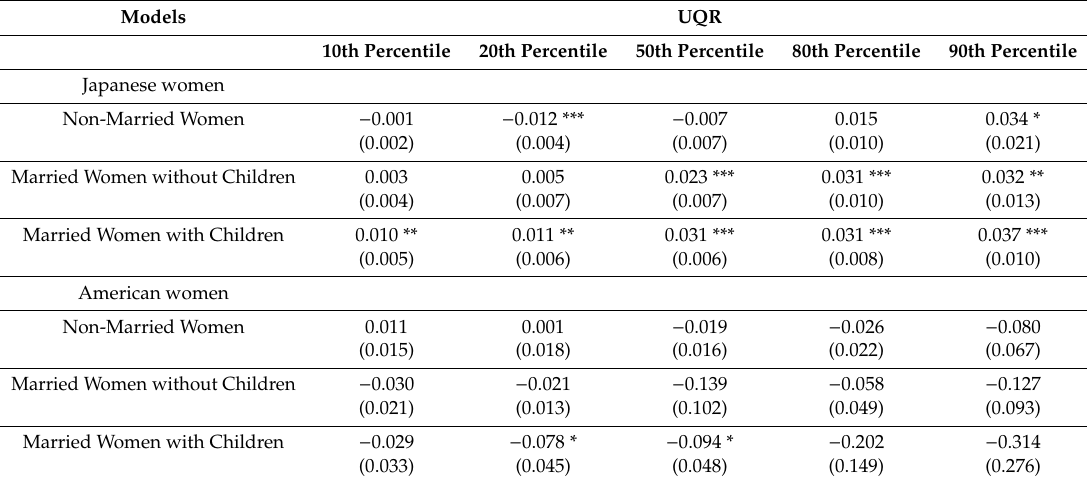
Table 3. Summary of unconditional quantile regression (UQR) results for Japanese and American Women Education’s Association with